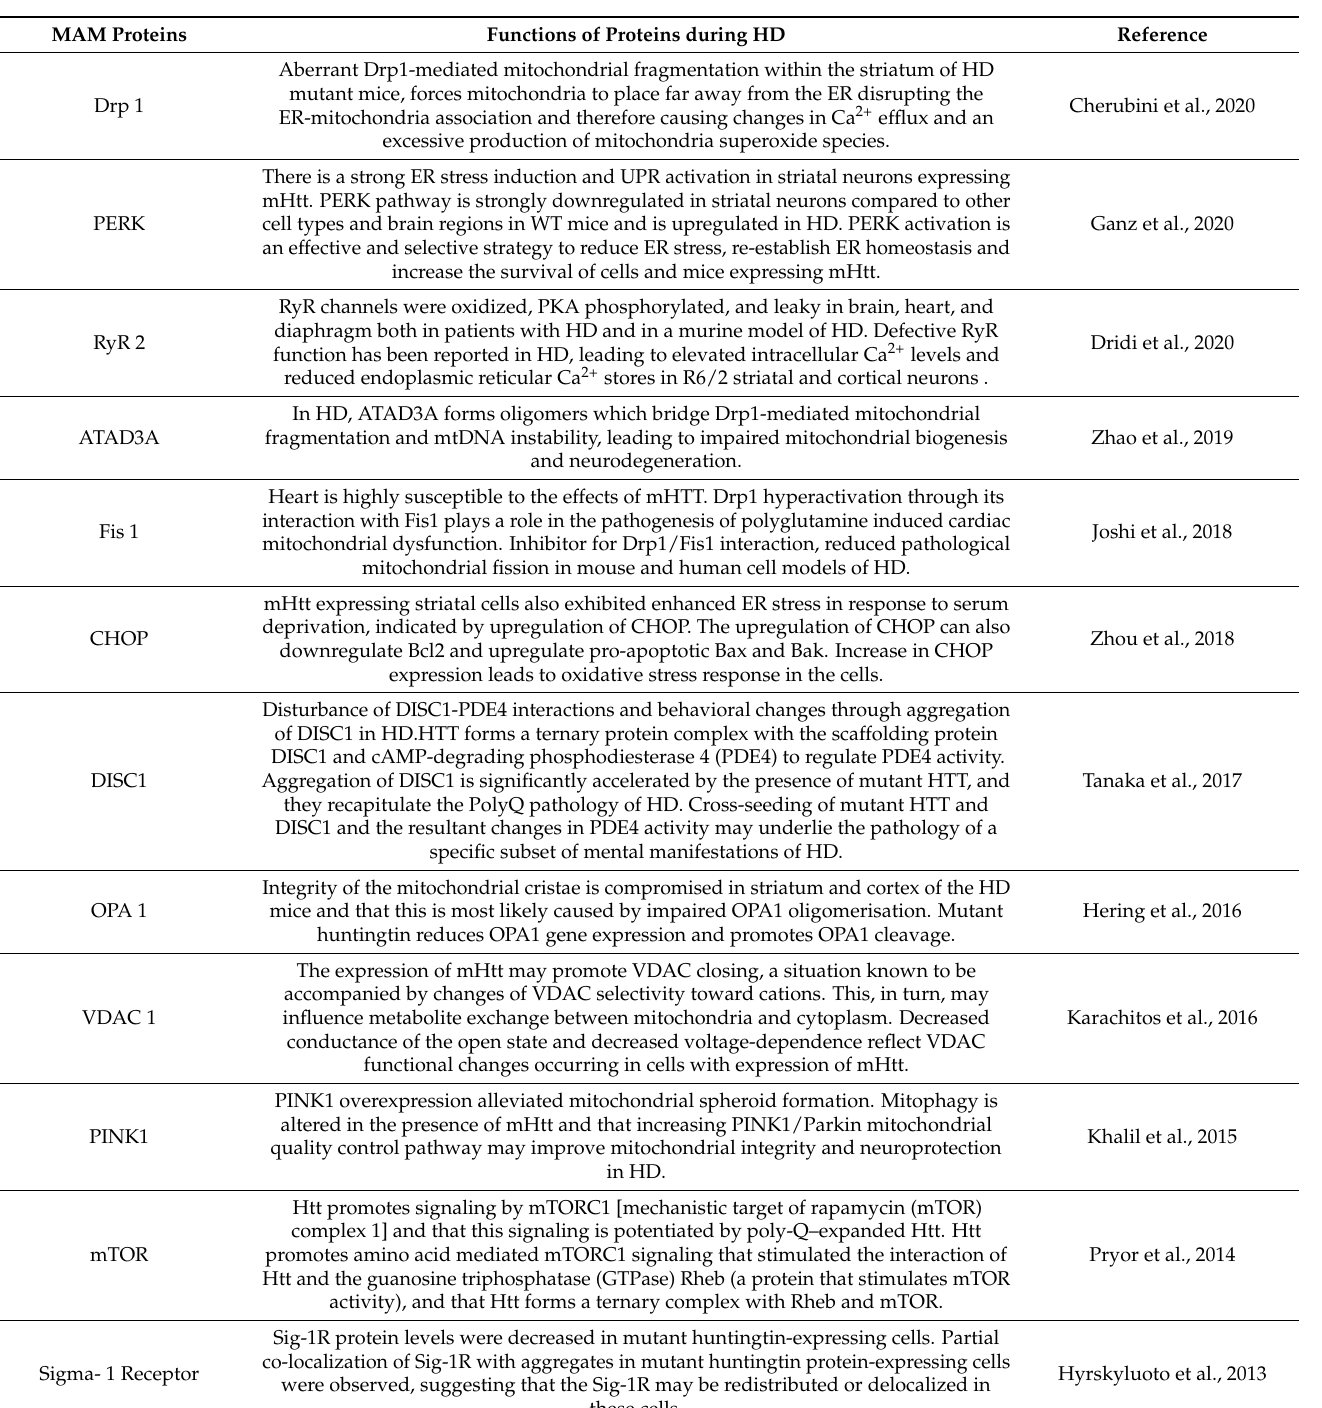
Table 2. Involvement of MAM proteins in